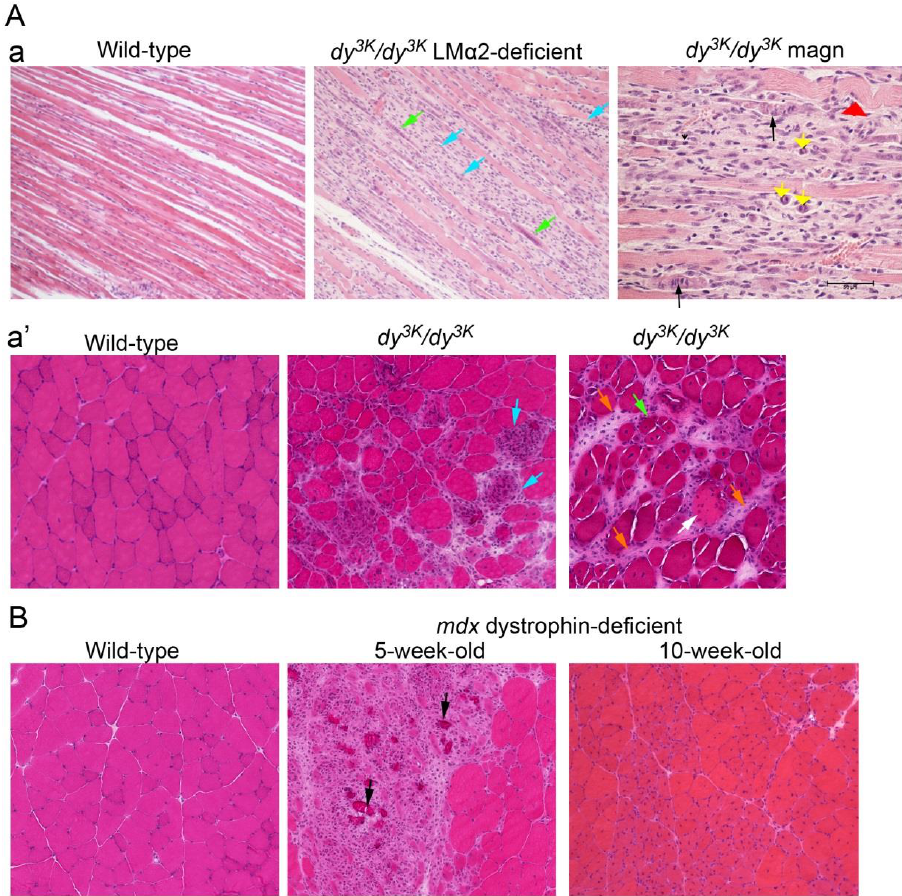
Figure 1. Common MD features on muscle biopsy. Muscles from animal models for MDC1A ( A ) and Duchenne MD ( B ) are shown. ( Aa , top panel ) Longitudinal sections of laminin α2 chain-deficient (LMα2) muscle from two-week-old dy 3K /dy 3K mice reveals a disruption of muscle fascicle: damaged and inflamed areas (blue arrows), small regenerating fibers with arrays of centrally-positioned nuclei (green arrows), dividing myoblasts (yellow arrowheads, magnified photo), regenerating fibers that are abnormal (undergo damage) (black arrows, magnified photo), and aberrant fibers (caterpillar shape, red arrowhead) are present. ( Aa’ , bottom panel ) Muscle cross-sections from four-week-old mice display: fiber size variation, acute inflammatory response at the damaged fibers (blue arrows), degenerating/apoptotic/necrotic fibers (white arrow), regenerating fibers with centrally-located nuclei (green arrow), and fibrotic lesions (orange arrows). Normal (wild-type) muscles with tightly packed rectangular fibers are shown for comparison. ( B ) dystrophin-deficient muscles of mdx mice display a dramatic disruption of the muscle fascicle with focal necrosis, inflammation, and calcified fibers (black arrowheads) at five weeks of age. In 10-week-old muscle, active regeneration takes place (fibers with centrally-located nuclei), muscle regains fibers and its condition is not equally severe. Bar: 50 μm.